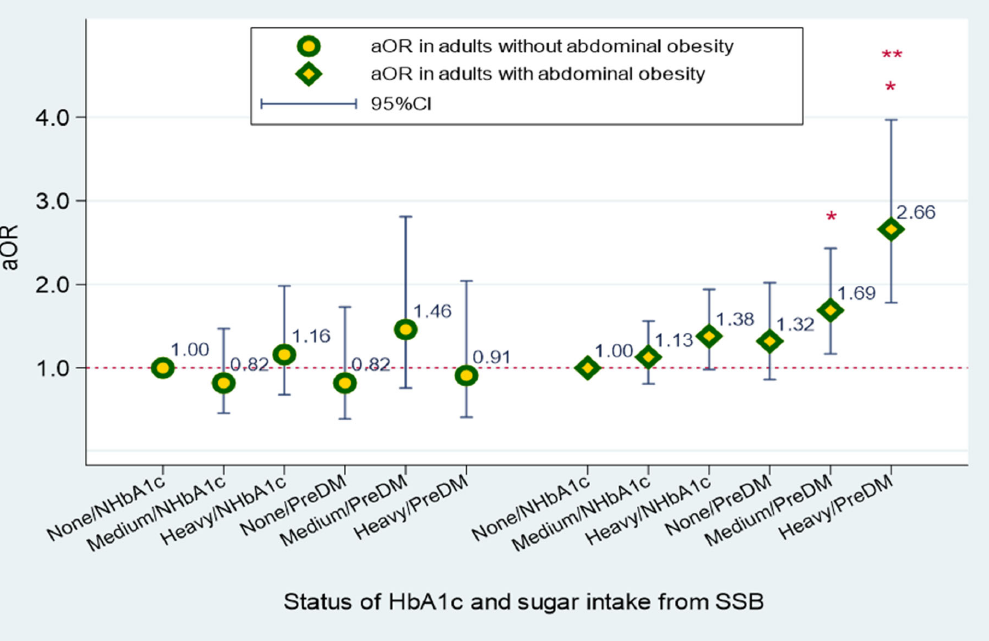
Figure 1. Effect modification of abdominal obesity on sugar intake from SSB and elevated